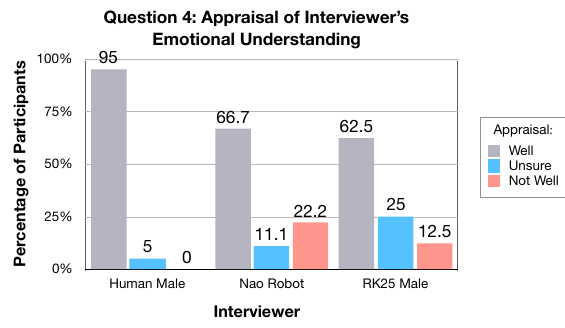
Question 4: Appraisal of Interviewer’s Emotional Understanding